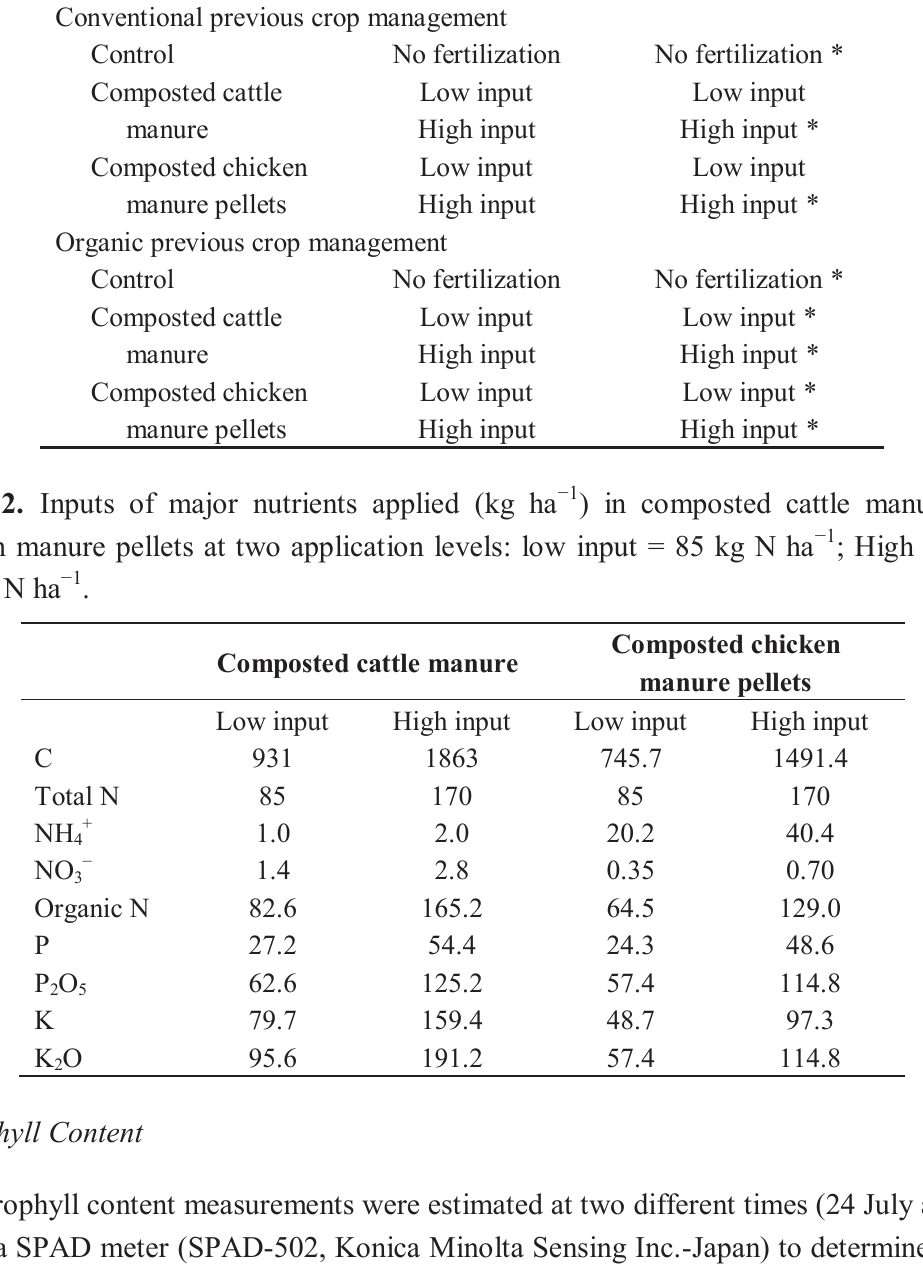
Table 1. Experimental design to illustrate the combination of watering regimes, previous crop management (soil from conventional or organic managed fields), and fertilization the eight treatments from which tubers samples were analyzed by 2D gel electrophoresis.